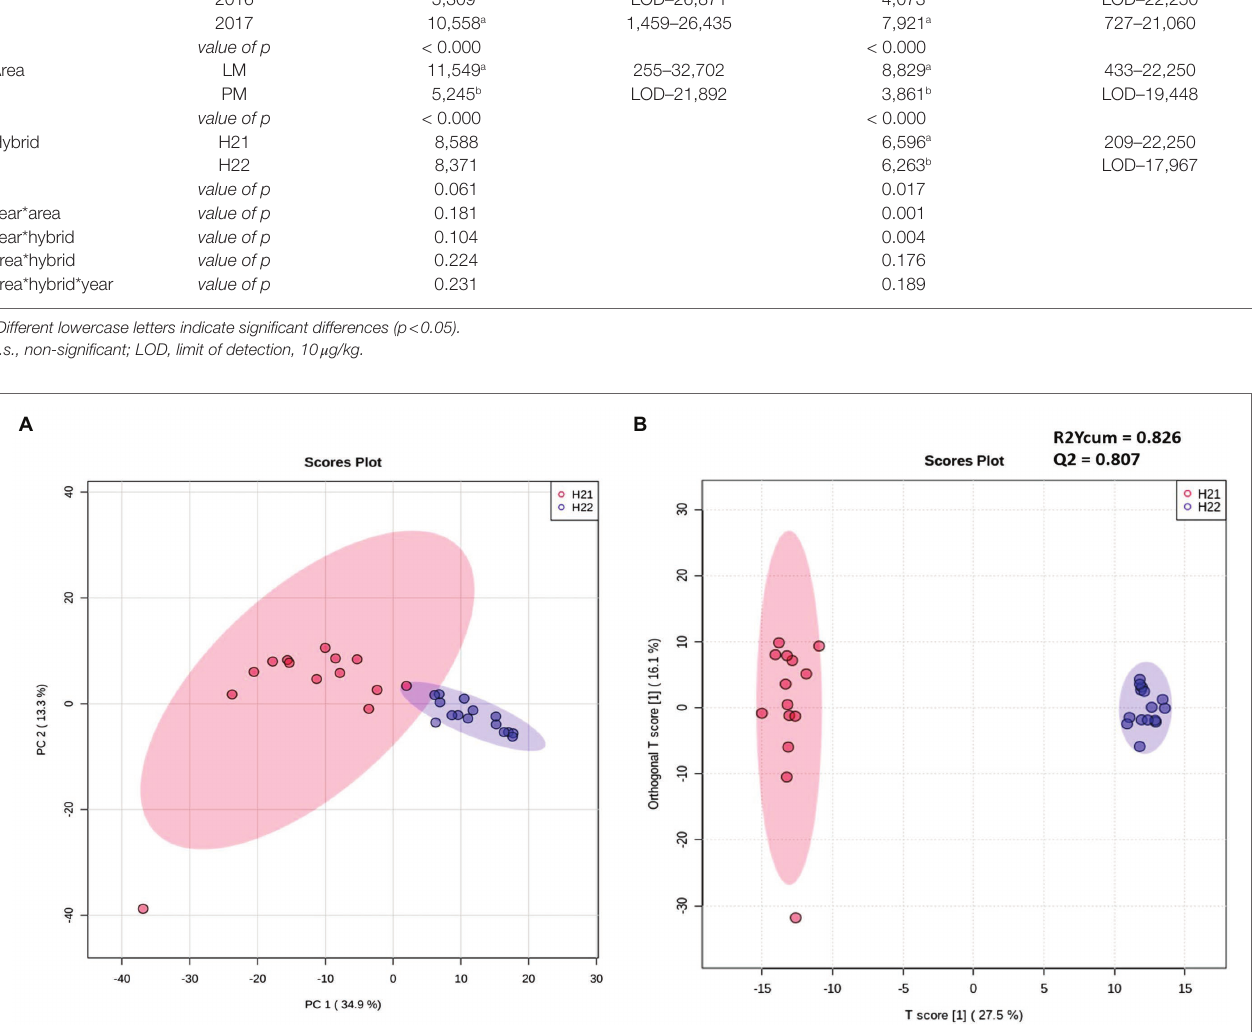
FIGURE 1 | Unsupervised (left) and supervised (right) statistical models of H21 and H22 samples. (A,B) Principal component analysis (PCA) score plot (A) and Orthogonal Partial Least-Square Discriminant Analysis (OPLS-DA; R 2 ycum = 0.826, Q 2 = 0.807) score plot (B) constructed using filtered data and colored according to the level of fumonisin contamination. Red and blue colors represent H21 and H22 samples,